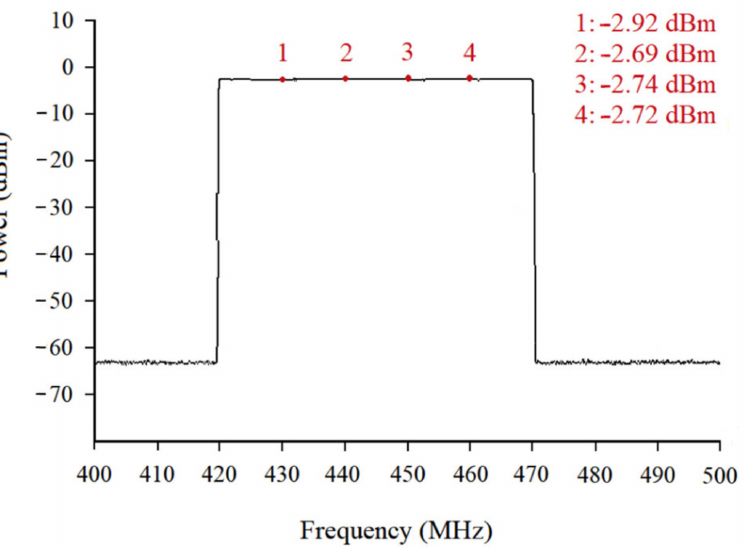
Figure 10. Output power for different frequencies within the working bandwidth of the plasma